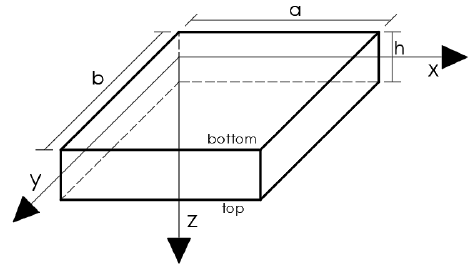
Figure 1. General laminate